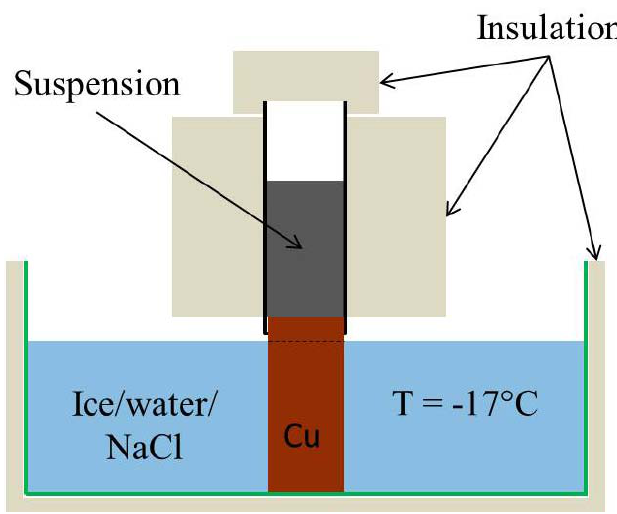
Figure 4. Schematic of freezing